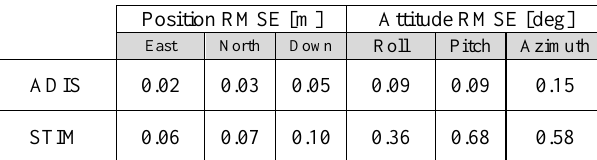
Table 1. PA RMSE for both IMUs using RTK position and velocity update